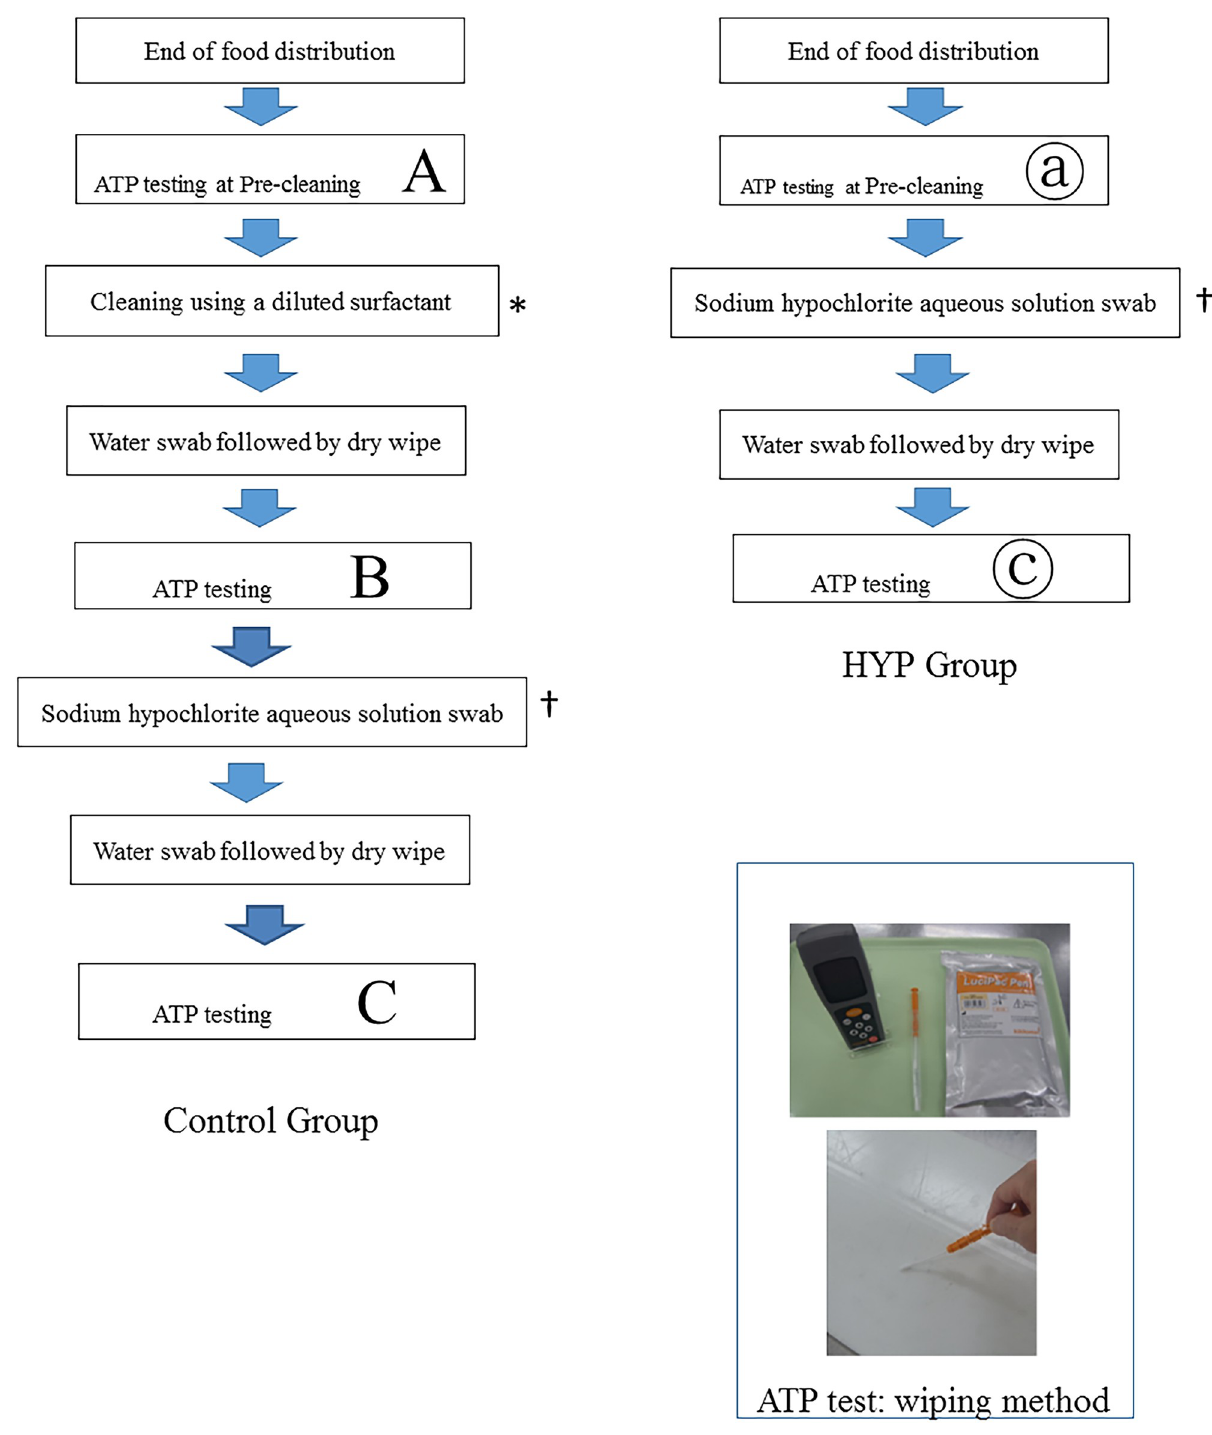
Fig 1. Evaluation of cleaning/disinfection by ATP testing. Experimental procedures for cleaning and disinfecting large equipment and facilities that could not be disassembled and disinfected using adenosine triphosphate (ATP) testing in the Shizuoka Cancer Centre Dietary Department Kitchen.